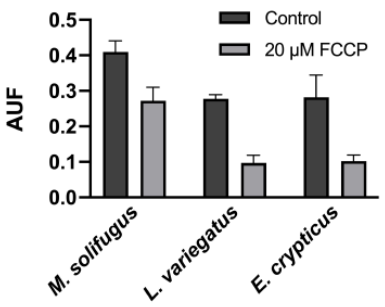
Figure 3. The differences in the levels of mitochondrial polyP observed in the annelids are not a consequence of a lack of mitochondrial membrane potential. All Annelida used to conduct this study had mitochondrial membrane potential, assayed by TMRM fluorescence. Data are expressed as mean ± SEM of, at least, three independent experiments, conducted using biological triplicates. Values of p ≤ 0.05 were considered significant.